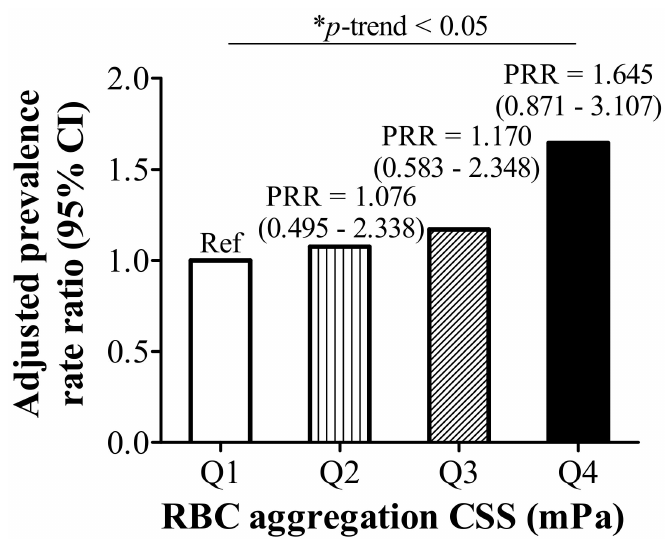
Figure 2. Prevalence rate ratio (PRR) and 95% confidence intervals of red blood cell (RBC) aggregation critical shear stress (CSS) quartile levels for hyperlipidemia adjusted by age, sex, and log-transformed body mass index (BMI); * p ≤